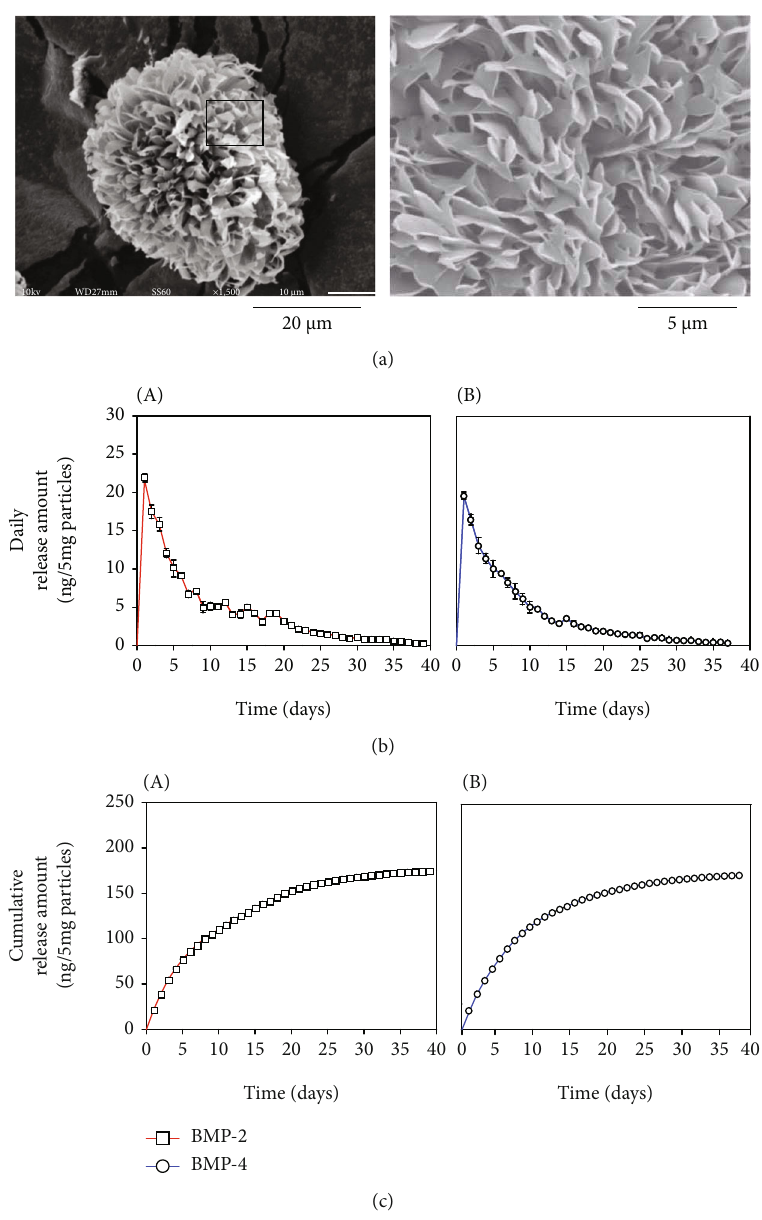
Figure 1: Sustainable release of BMP-2 and BMP-4 by using the microparticles of the entire leaf-stacked structure (LSS). (a) Scanning electron microscopic structure of the surface of an ELSS microparticle. (b) Daily release amounts of BMP-2 (A) and BMP-4 (B). The release behavior was analyzed daily using 5mg of particles and continued until 0.2ng of each BMP was released. The releases of BMP-2 and BMP-4 were analyzed for 39 days and 37 days, respectively. (c) Cumulative release amounts of BMP-2 (A) and BMP-4 (B). Over 39 days and 37 days, the cumulative release amounts of BMP-2 and BMP-4 per 5mg of particles were 174.93ng and 194.26ng,